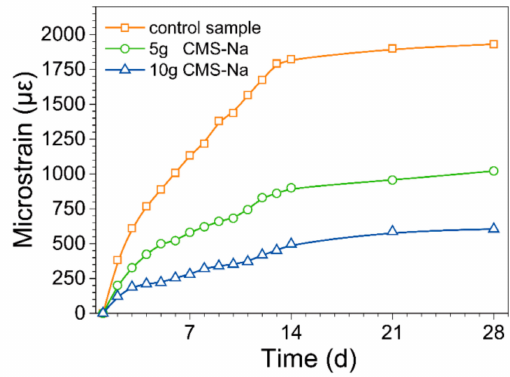
Figure 7. E ff ect of CMS on the drying shrinkage of AAM paste with curing time evolution.